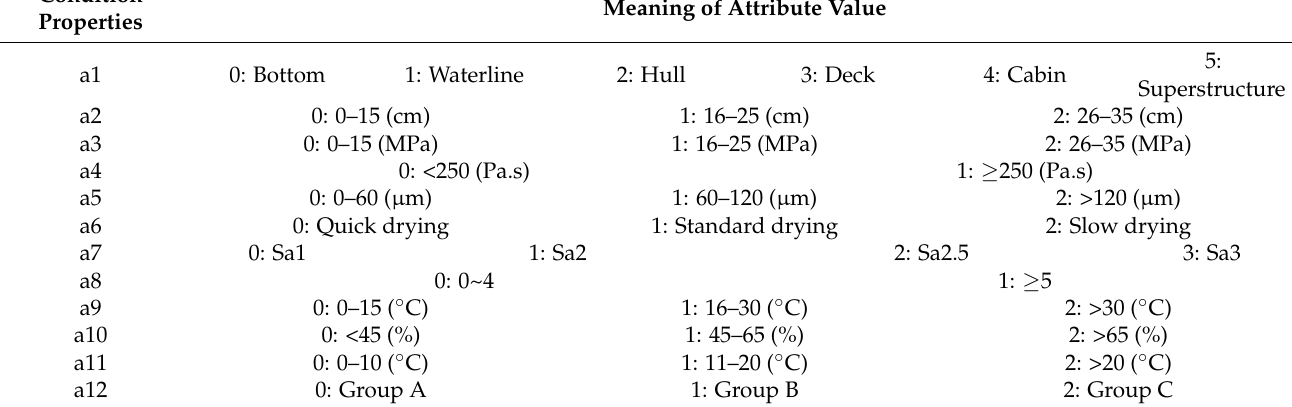
The algorithm parameter settings are shown in Table 7. In the table, P c 1 and P c 2 are crossover probability control factors, P m 1 and P m 2 are mutation probability control factors,